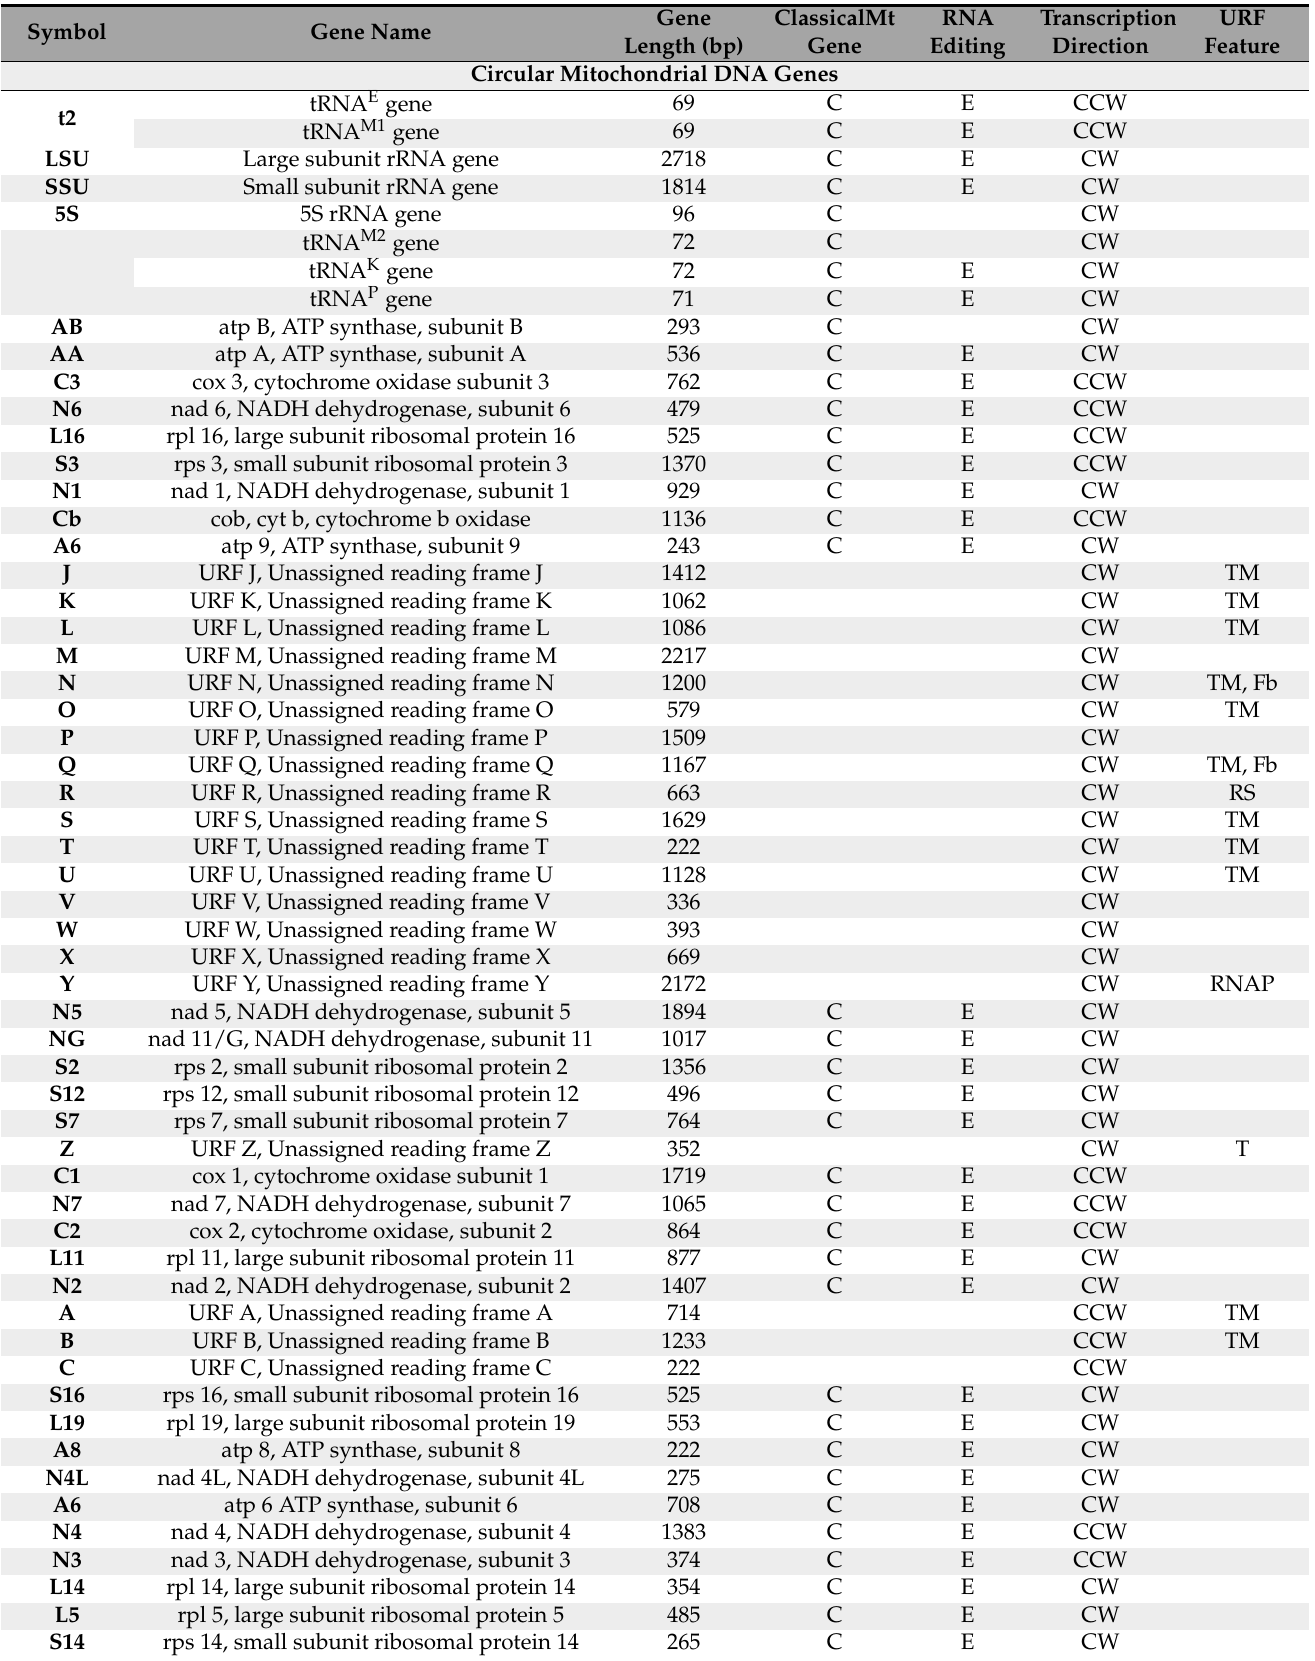
Table 1. Gene Symbols used in